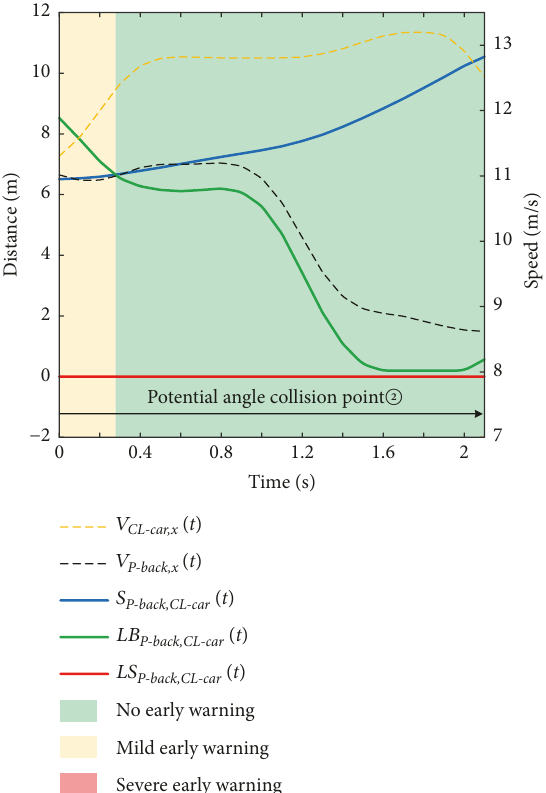
Figure 22: Distance and speed change between P-back and CL-car